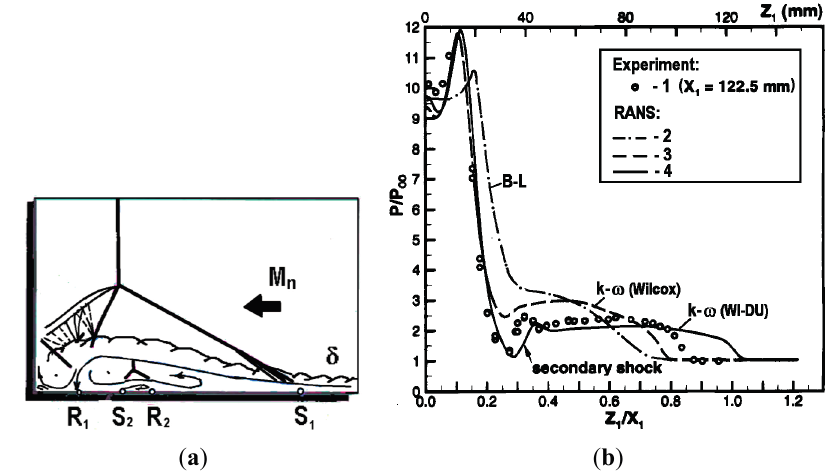
Figure 5. Single fin flow at α = 30.6°, M ∞ = 4, Re δ o = 1.6 × 10 5 : ( a ) flowfield schematic in a cross section and ( b ) wall pressure distribution. Reprinted [17] by permission from the author.